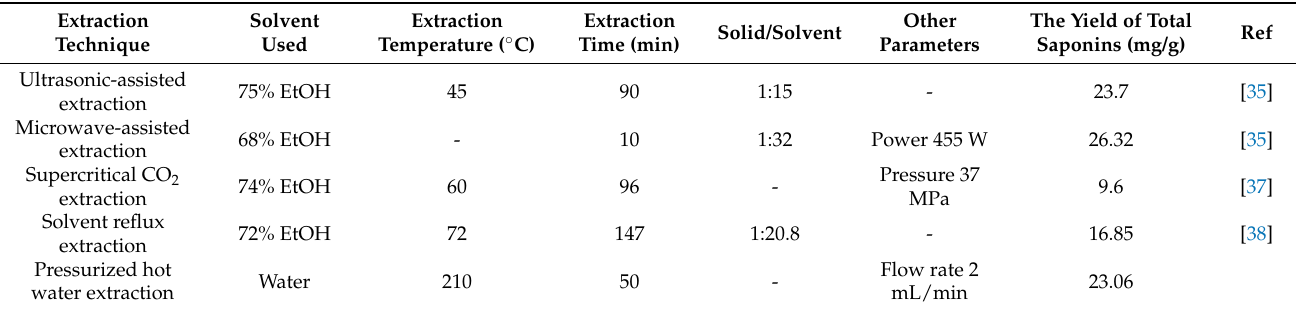
Table 3. Comparison of total saponins extraction technology in quinoa husks.